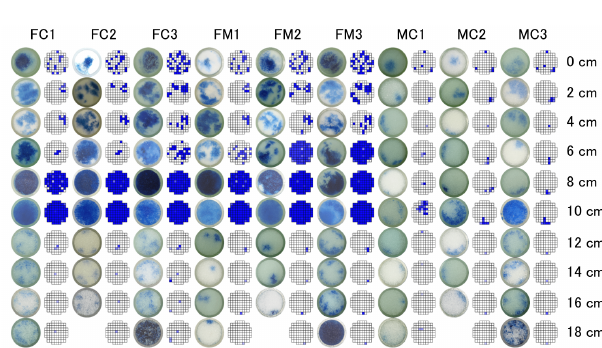
Figure 3. Liquid water distribution (blue shading) at the end of each experiment and simulation. The coordinate on the right denotes the depth of the section from the top surface.